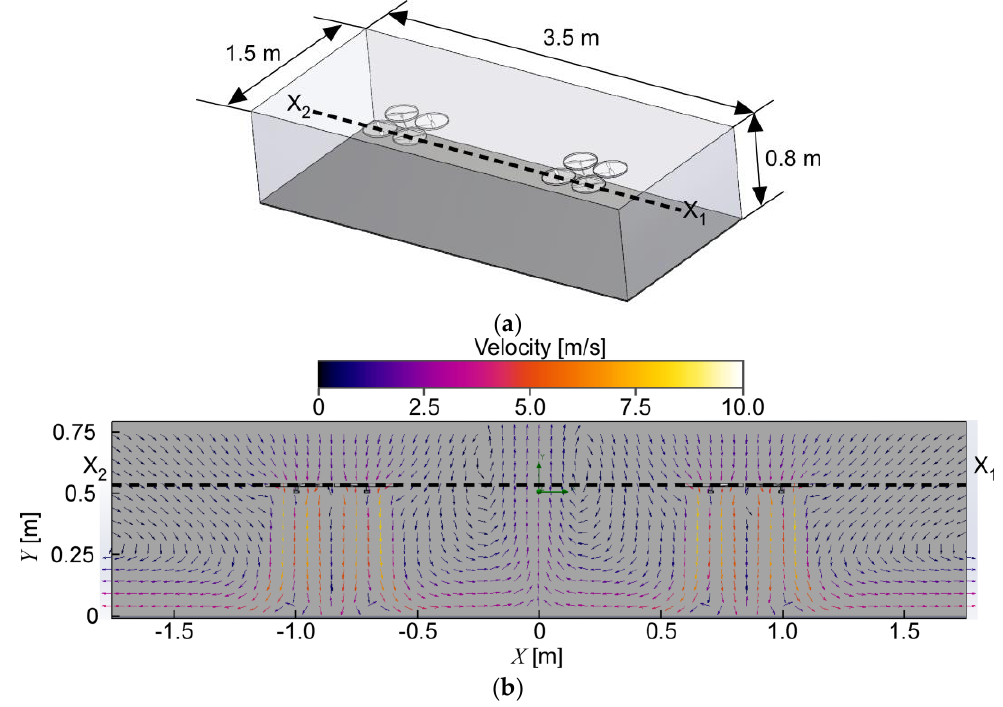
Figure 3. Result of computational fluid dynamics (CFD) simulation. ( a ) Computational domain prepared for simulating the airflow generated by the connected quadcopters; ( b ) velocity distribution in a vertical cross-section that intersects the quadcopters at line segment X 1 X 2 .